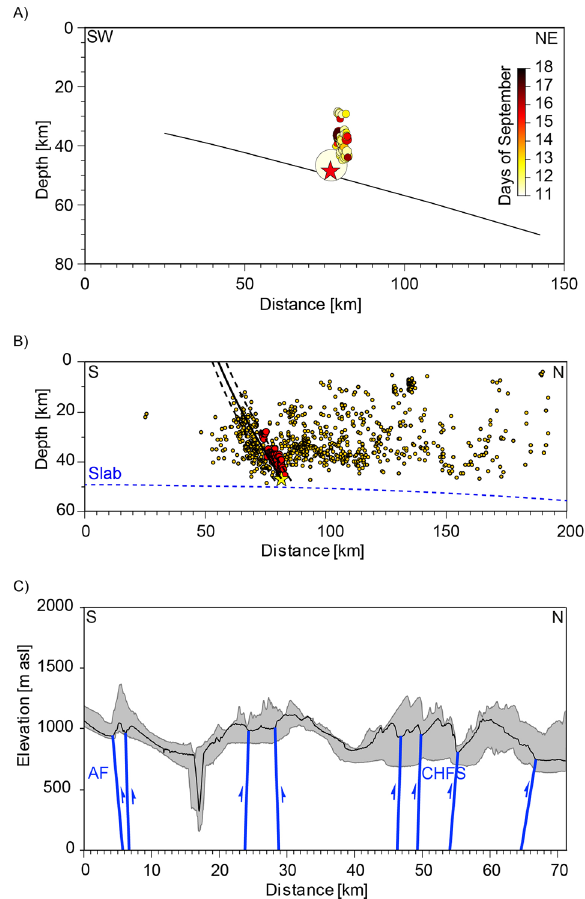
Figure 3. (A) Vertical section in the NE-SW direction showing the distribution of mainshocks and aftershocks. The colour scale represents the number of days after the mainshock. The thin black line represents the interplate contact projected in the section. (B) The NS vertical section shows the distribution of upper plate earthquakes (orange circle) of the catalogue of Sippl et al. 7 and red circles show the HypoDD relocated aftershocks of the M w 6.3 event (yellow star). The segmented blue line projected in the section is the slab 2.0 model. The black continuous and segmented lines represent the Cerro Aguirre Fault in the section. (C) The NS swath profile of the topography of the Coastal Cordillera shows the interpretation of trench-orthogonal reverse faults. The swath profile was created with ArcGIS 10.8.2 (https:// www. esri. cl/ es- cl/ inicio) based on the 12.5-m DEM provided by open-access ALOS PALSAR data (https:// search. asf. alaska.